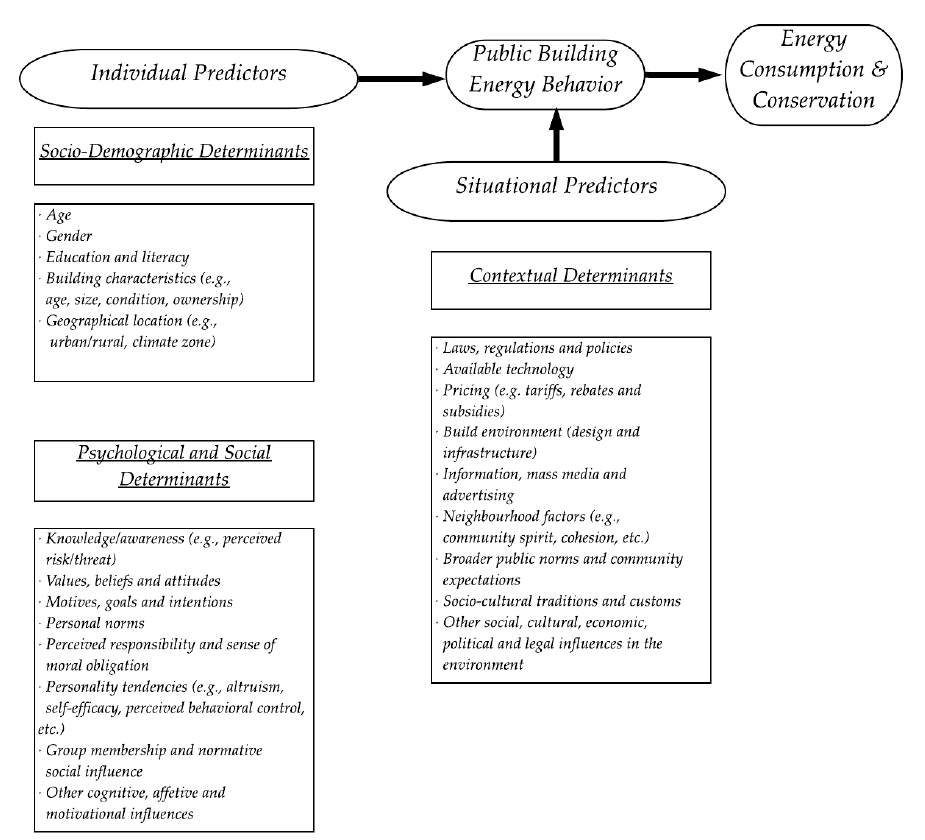
Figure 1. Determinants that may influence energy-saving behavior in schools. Adapted for public buildings under Frederiks et al. [21]. 123